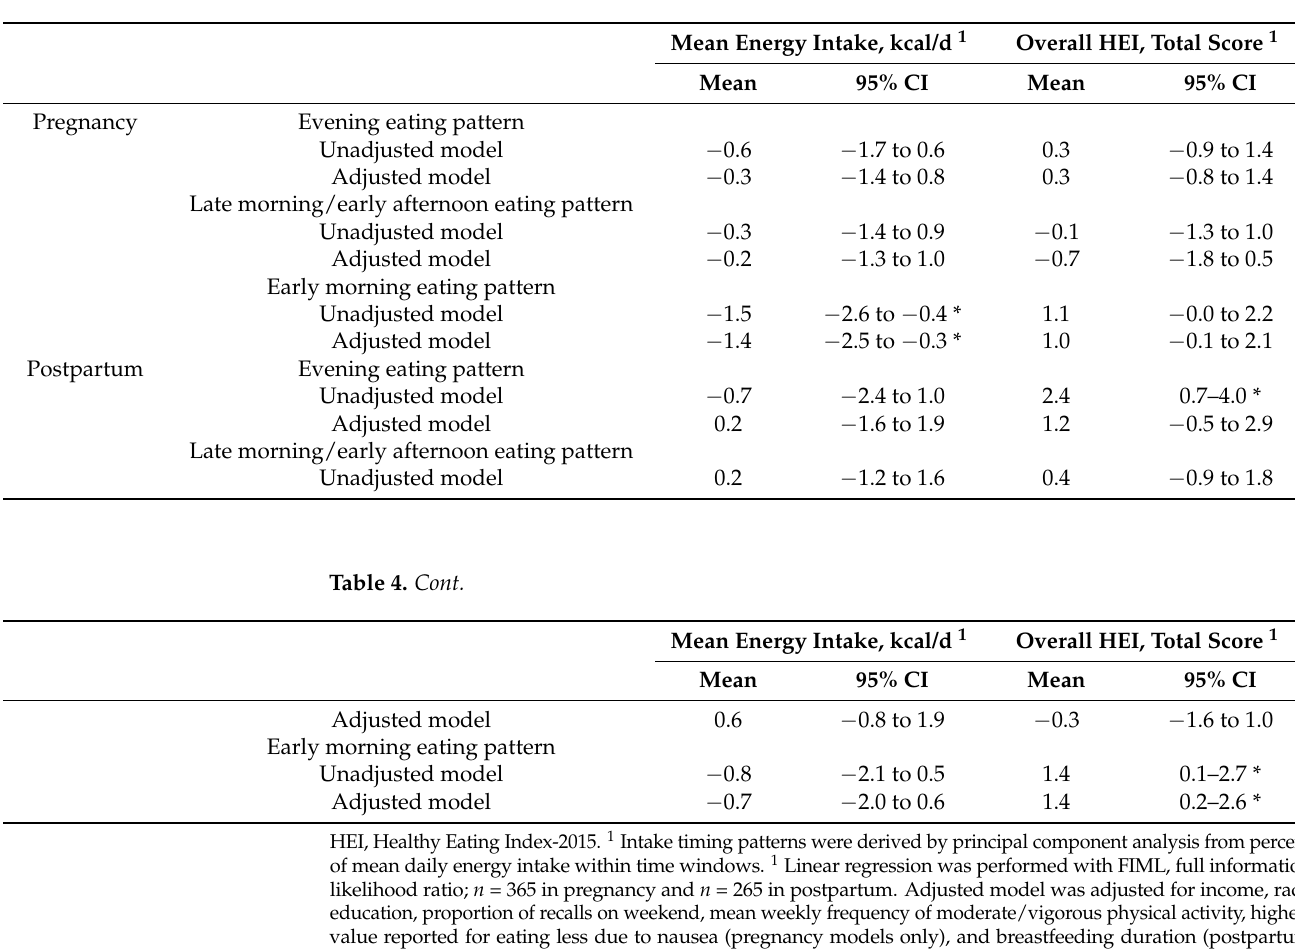
Table 4. Associations of intake timing patterns with mean energy intake and overall